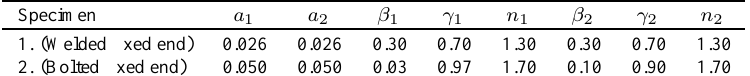
Table 1 Identified model parameter values for the two experiments